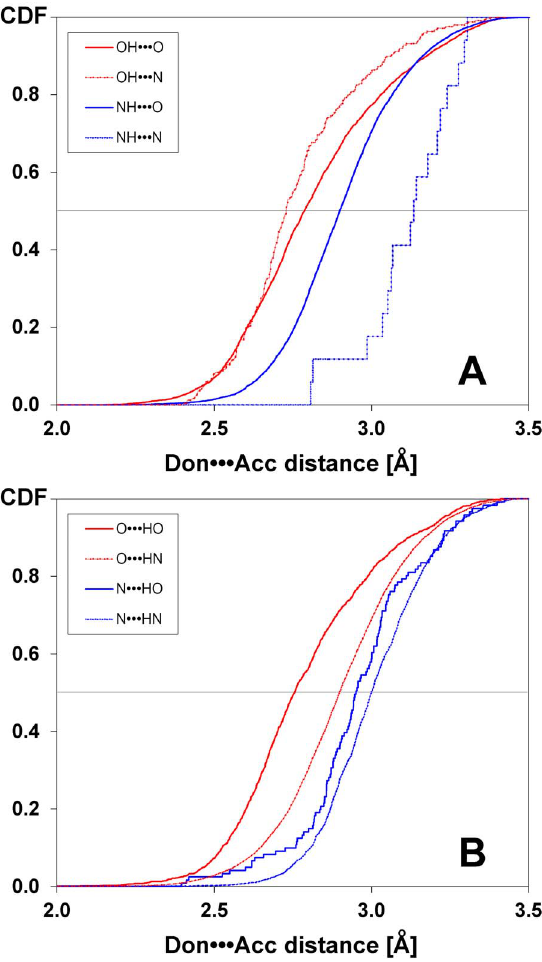
Figure 1. Cumulative distributions of donor-acceptor distances determined for various types of intermolecular hydrogen bond donor-acceptor pairs identified in complexes of proteins with non-halogenated ligands, in which the ligand is either a hydrogen bond donor (A) or acceptor (B).